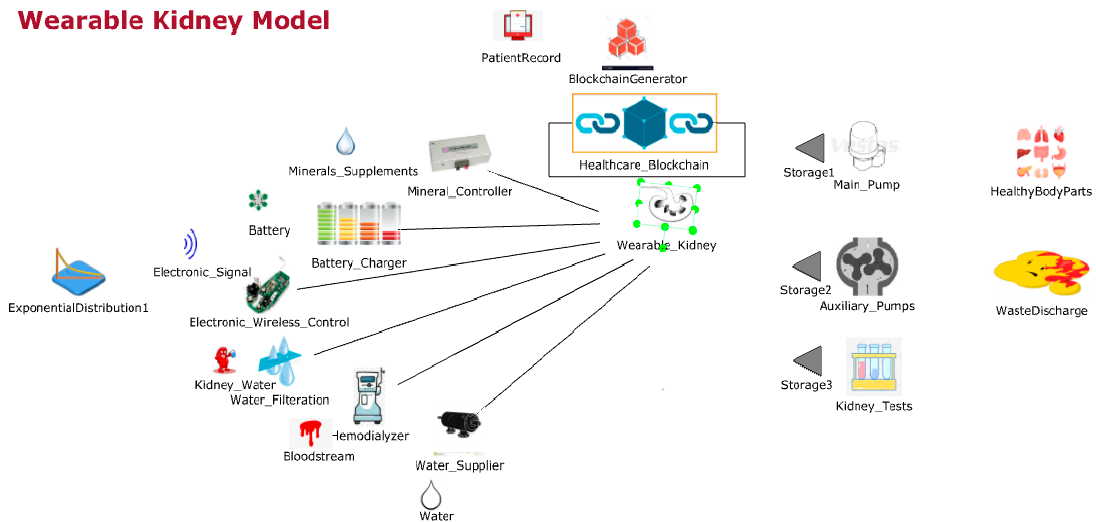
Figure 3. Wearable kidney monitoring system with blockchain technology.